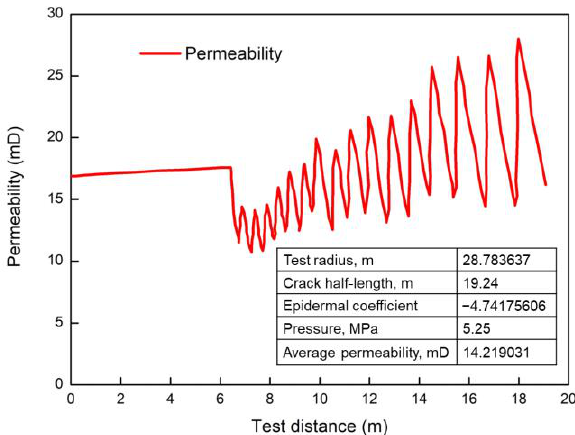
Figure 21. Coal seam cleaning fluid pressure drop test.